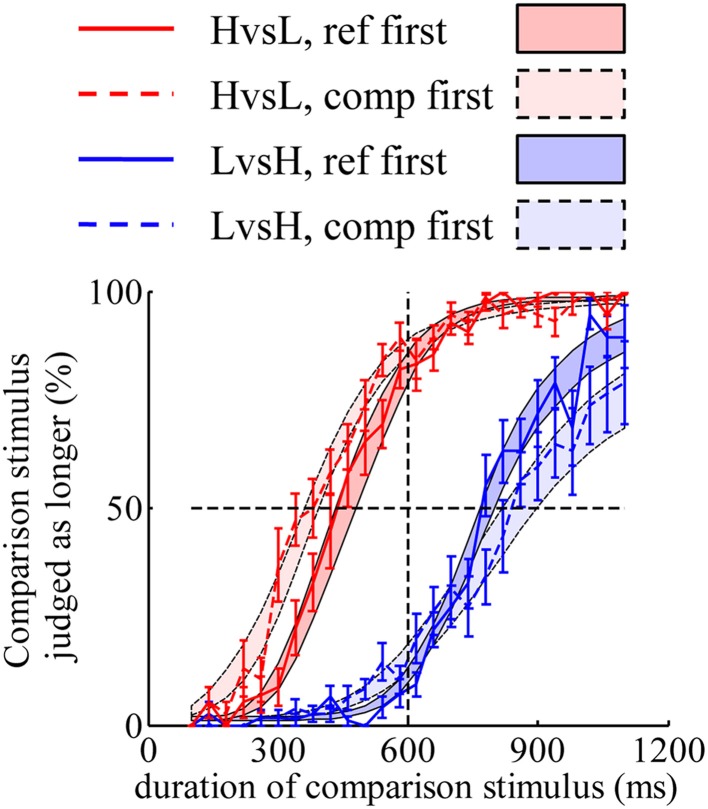
A model constructed with “decay” and “double-priors” hypotheses captures the discrepancy in psychometric curves observed in Experiment 1. Shaded areas represent the predicted choice probabilities.